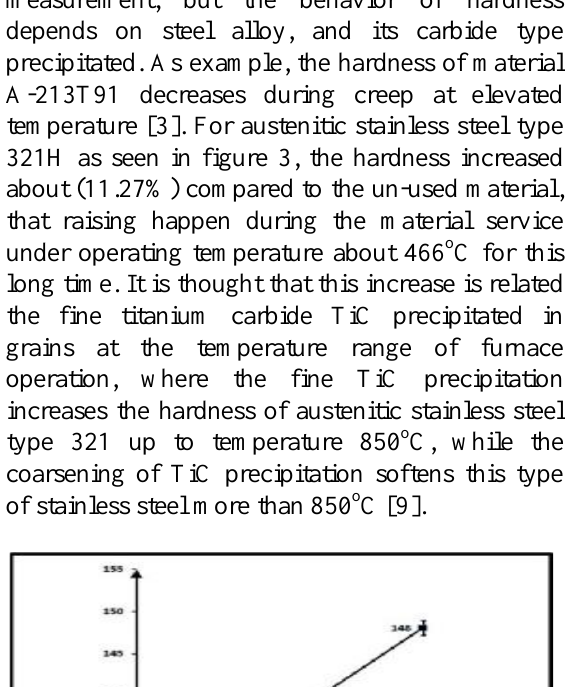
PDF created with pdfFactory trial version